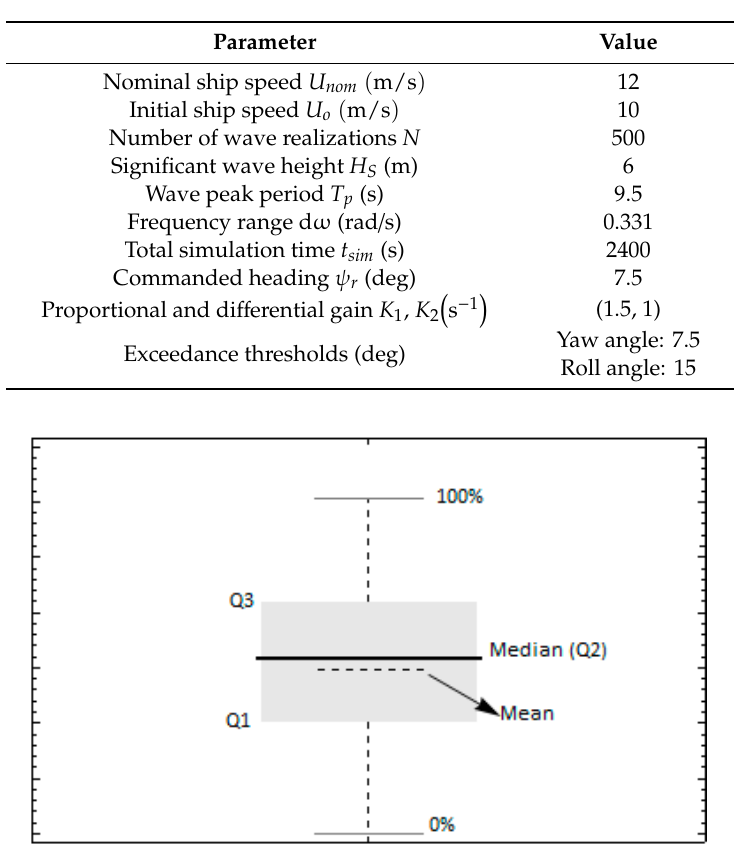
Table 1. Parameters of the base scenario.